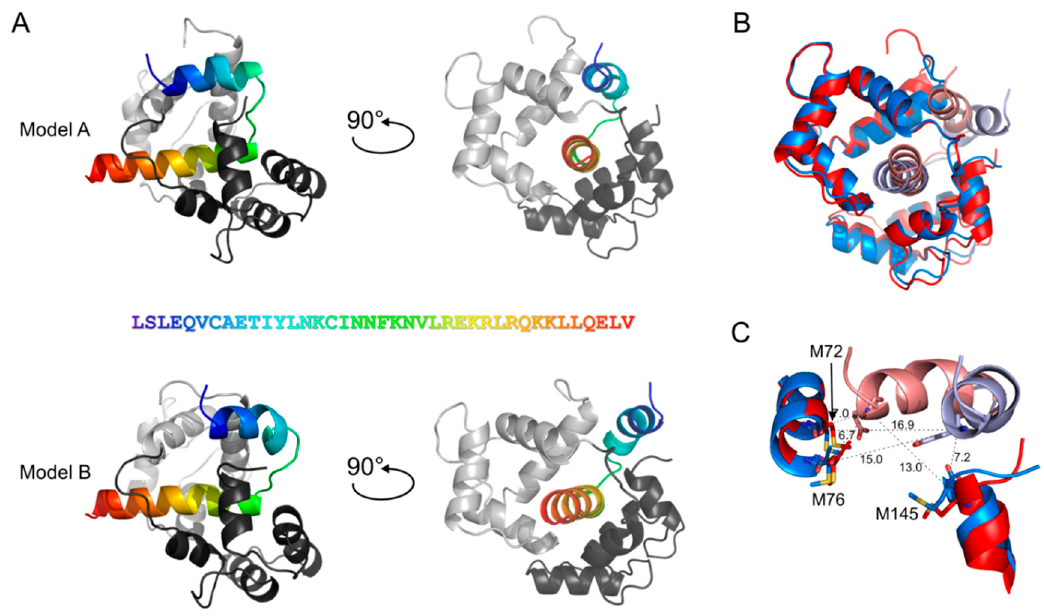
Figure 4. Models of bMunc13-2 segment-C (aa 704–742) with CaM generated by ROSETTA. Segment-C was docked into CaM (PDB-Code: 2O60). The N -terminus of bMunc13-2 segment-C interacts with the central α -helix (Model A) or the C -terminal amino acids of CaM (Model B). ( A ) The N -terminal EF-hands of CaM are colored in light gray, the C -terminal EF-hands are colored in dark gray; aa 704–742 of bMunc13-2 are highlighted in rainbow colors starting with blue from the N -terminus; the amino acid sequence is given. ( B ) Superimposition of Model A and B (RMSD of 3.04 Å). Red: Model A, blue: Model B; bright colors: segment-C, dark colors: CaM. ( C ) Zoom into the slight flexibility of the N -terminus in segment-C; aa 704–718 are displayed for segment-C, aa 67–77 and aa 139–148 for CaM. C α –C α distances are shown for the cross-links connecting E707 of segment-C with the respective Met residues of CaM, which are replaced by photo-Met for cross-linking. Red: Model A, blue: Model B; bright colors: segment-C, dark colors: CaM.